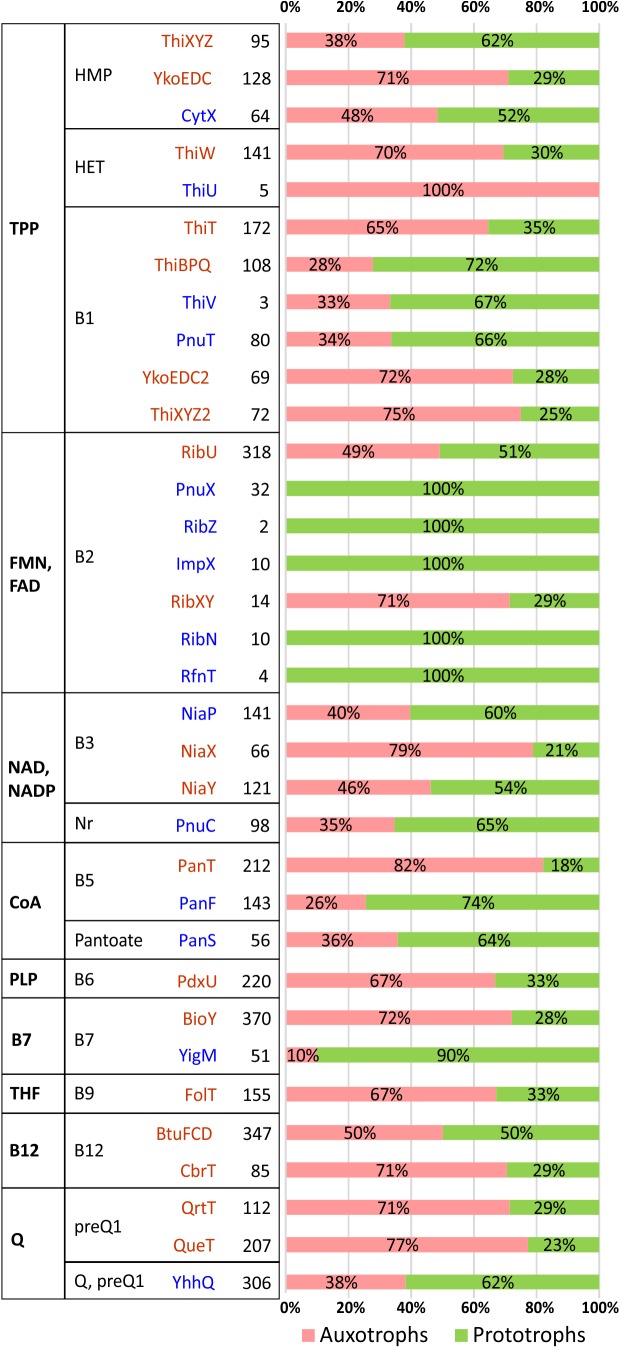
Distribution of vitamin/vitamer transporters in HGM species. Transporters are grouped by a cofactor (first column) and vitamin/vitamer (second column). Primary active transporters from the ABC or ECF family are shown in dark red, while secondary active transporters/facilitators (e.g., permeases from MFS family) are in blue. The total number of species possessing a specific transporter is shown in bold with relative contribution of corresponding vitamin auxotrophs/prototrophs shown as a pink/green bar.